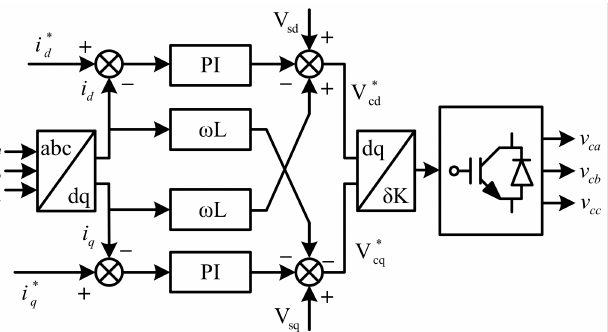
Figure 3. Decoupled current control approach between the real and reactive power in a STATCOM.